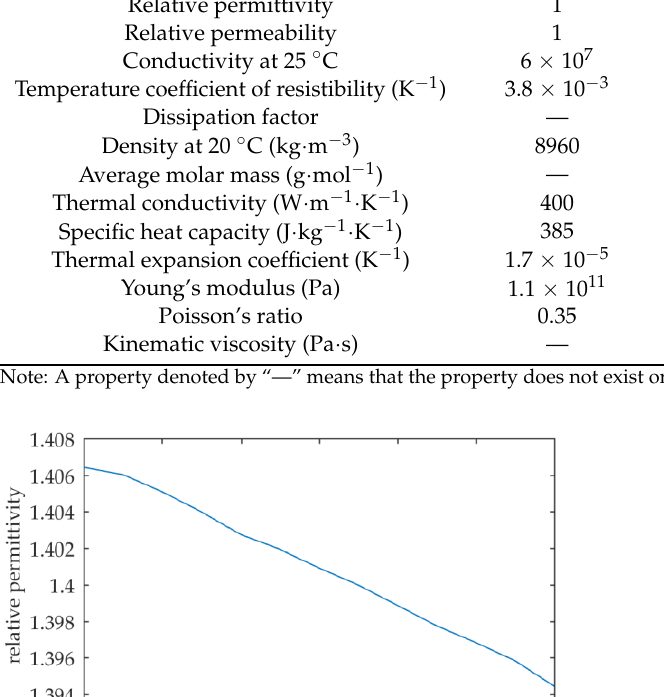
Table 2. Material Properties.